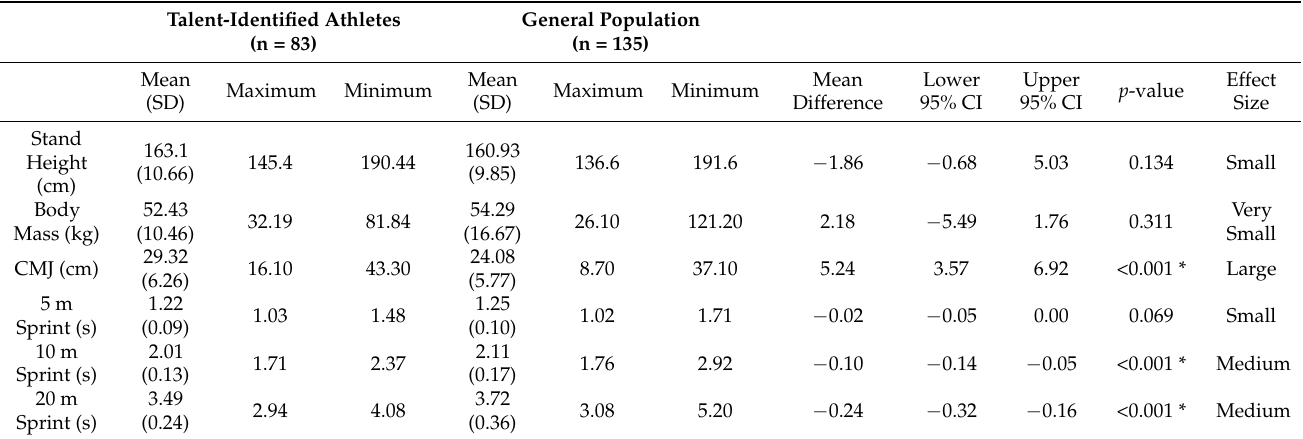
Table 2. Descriptive statistics with group difference for male talent-identified athletes and the general population counterparts for the physical performance